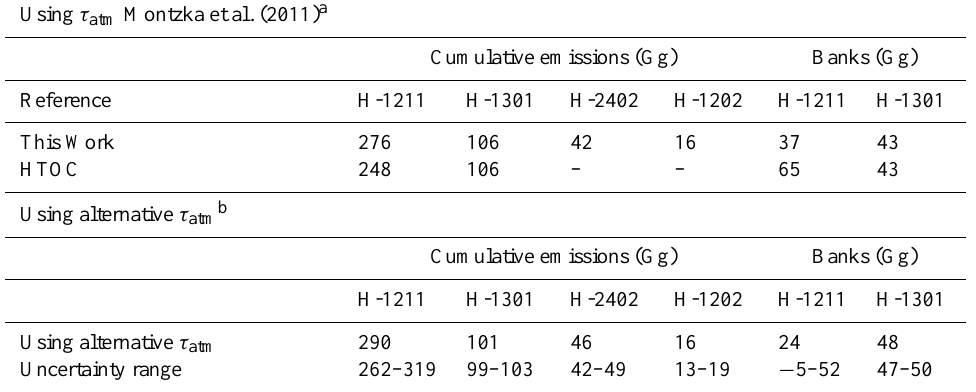
Table 2. Estimates of the cumulative emissions of the halons between 1963 and 2010 reported by HTOC (bottom-up estimate) and calculated in this work using firstly the lifetimes reported by Montzka et al. (2011) and secondly the alternative lifetimes calculated in this work (Sect. 8). Also shown are the banks of H-1211 and H-1301 that are calculated by subtracting the specific estimates of the cumulative emission from the estimates of cumulative production as reported by HTOC (HTOC, 2011). Using τ atm Montzka et al. (2011)